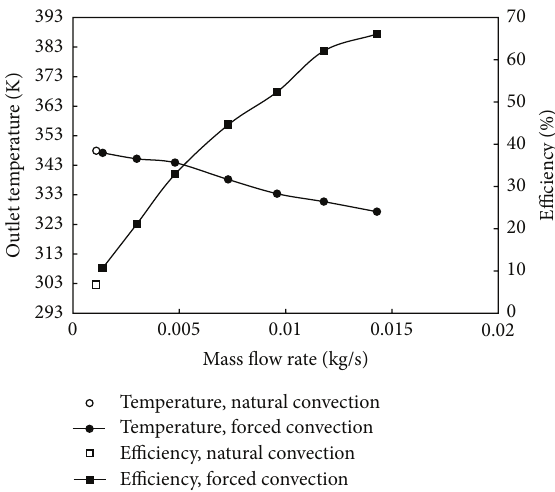
Figure 7: The maximum temperature and mass flow rate with various lengths of airflow.